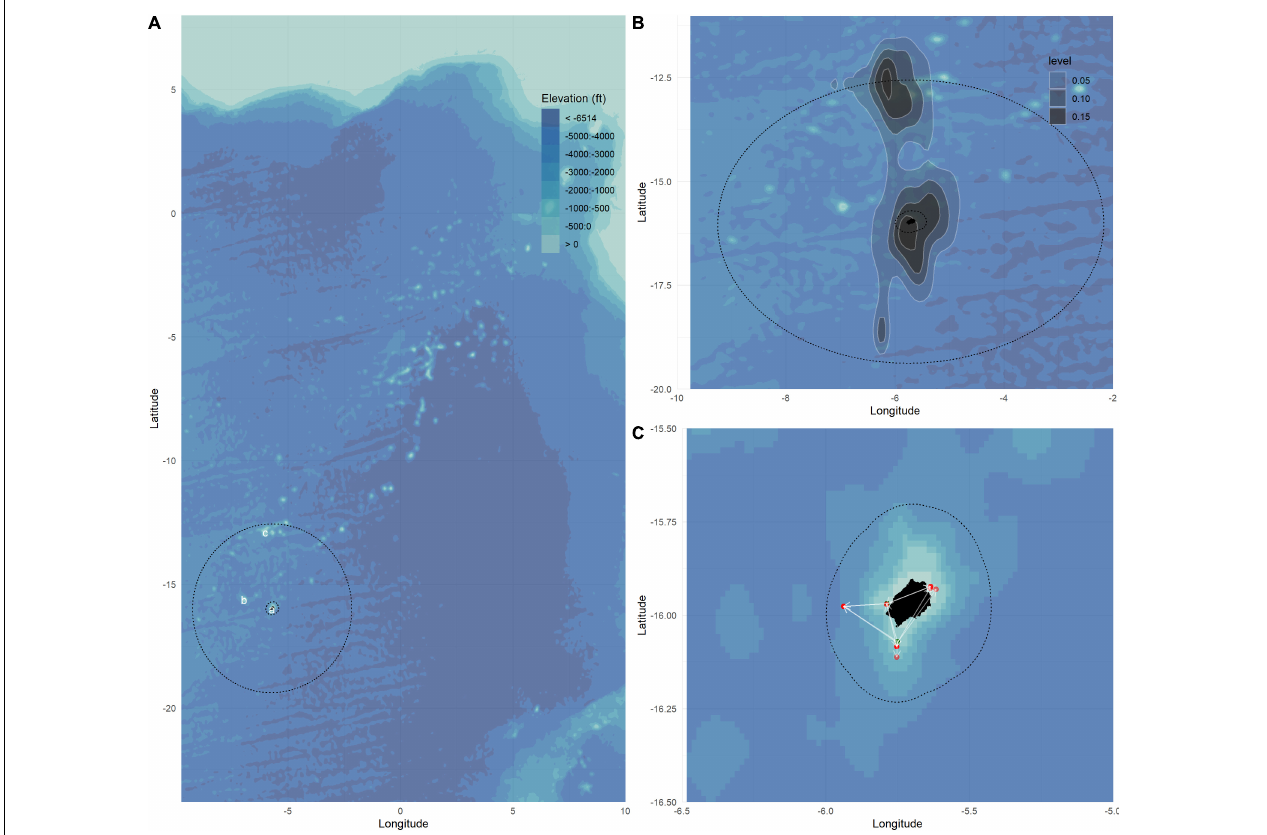
FIGURE 1 | (A) The St Helena Exclusive Economic Zone (EEZ) in the South Atlantic including the fishing regions inshore (a) , Bonaparte Seamount (b) , and Cardno Seamount (c) . (B) Map showing the kernel density of daily position estimates from satellite tagged tuna, and (C) release (green) and recovery (red) locations for archivally tagged yellowfin tuna. Bathymetry provided from the General Bathymetric Chart of the Oceans, GEBCO (ca. 1 km grid size) (Schenke,